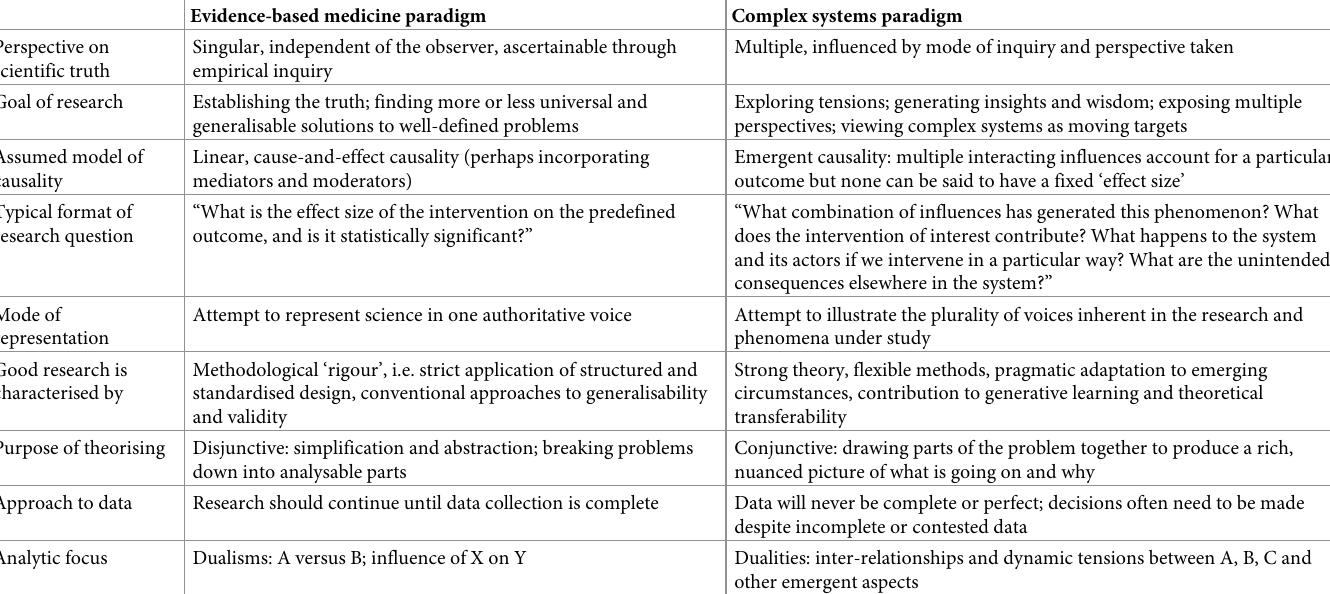
Table 1. Evidence-based medicine versus complex systems research paradigms. Adapted under Creative Commons licence from Greenhalgh and Papoutsi [16]. Evidence-based medicine